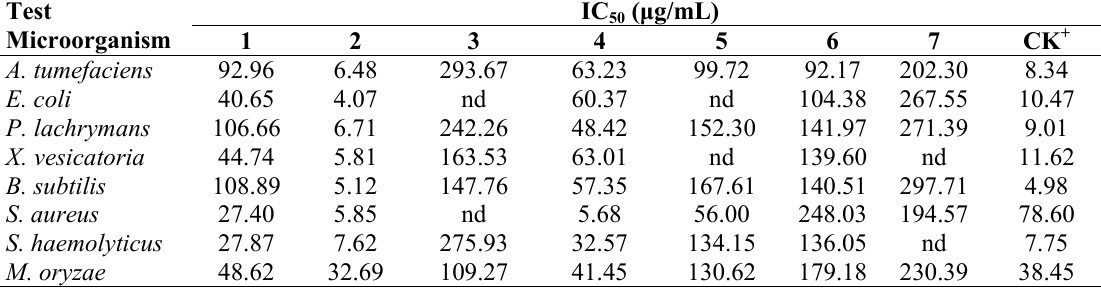
Table 2. IC values of the flavonoids from H. caspica on microorganisms. 50 Test